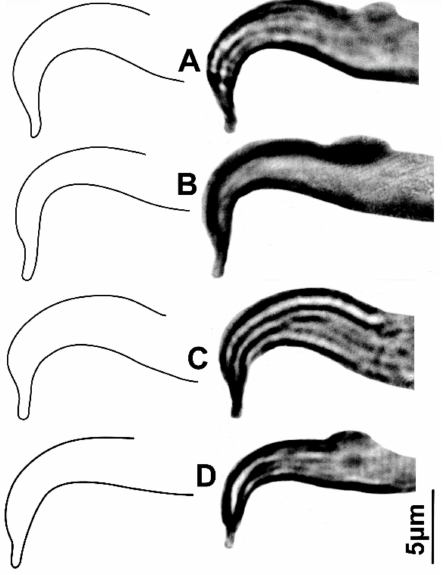
Figure 5. Illustrations/images of male aedeagi ( A – D ) drawn from four specimens of the claimed Oligonychus punicae population [37] collected from Alnus jorulensis in Mexico (voucher no. 52; Table S1), which needs to be re-identified.